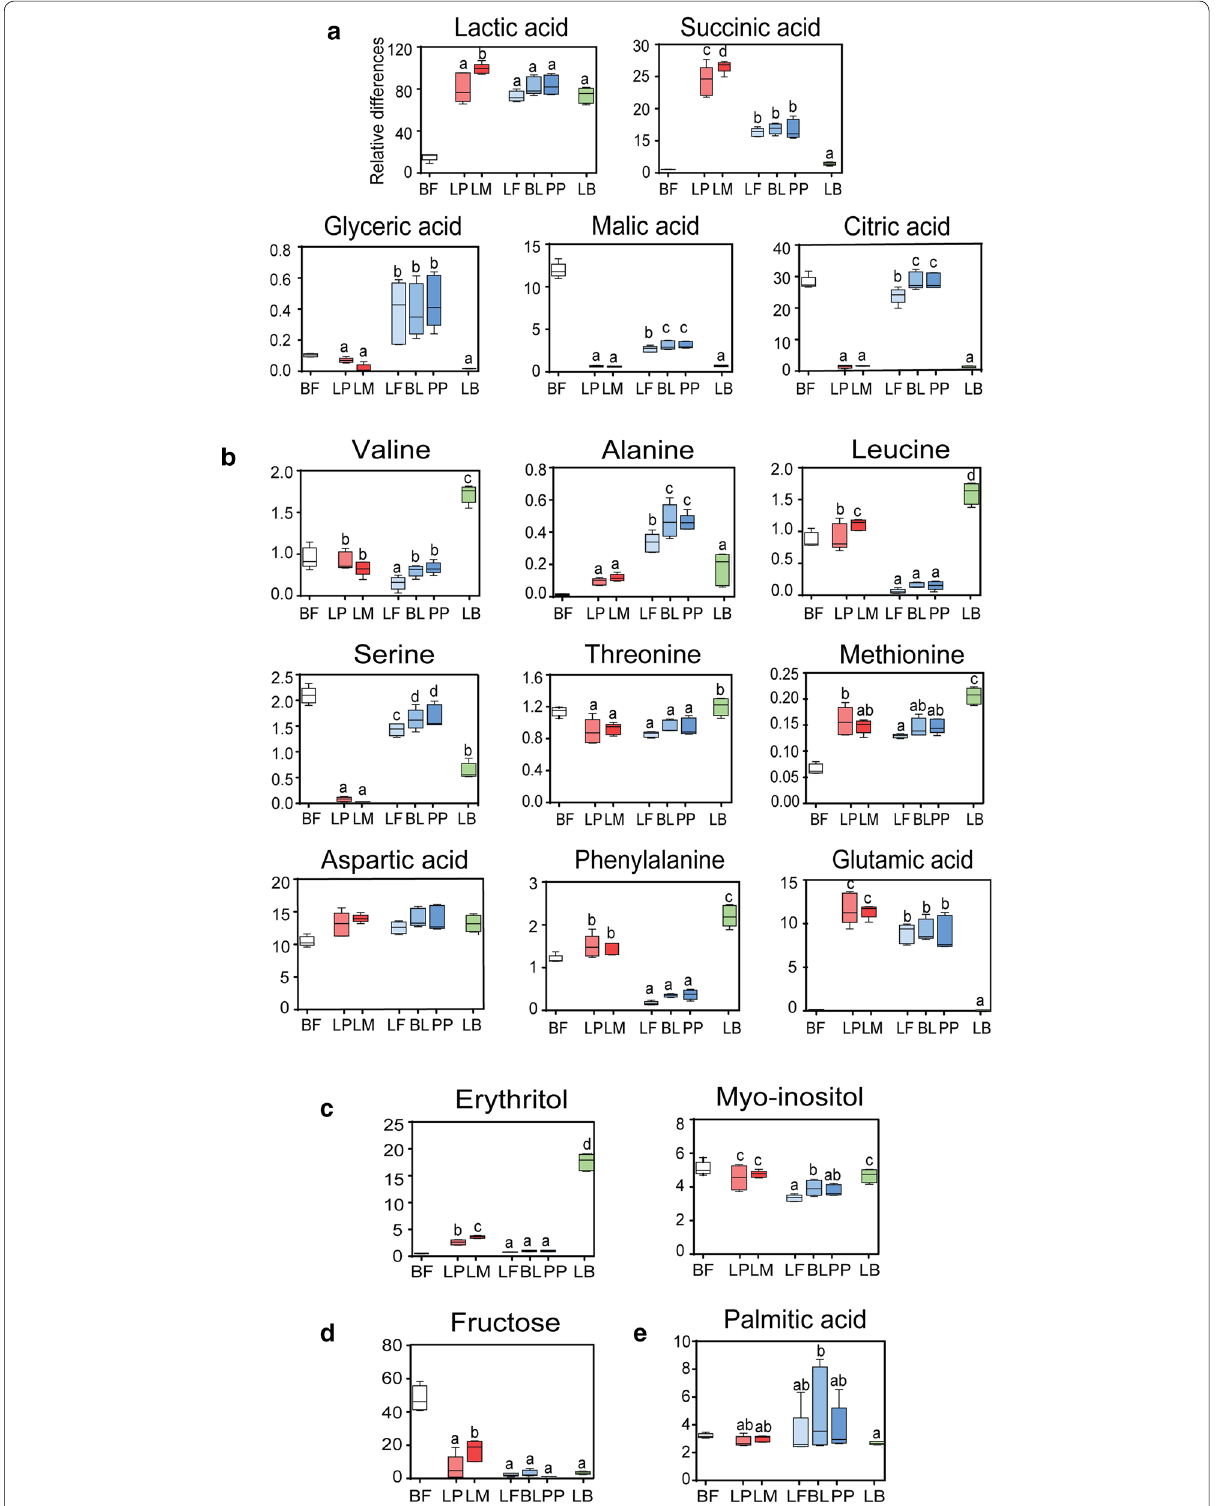
Fig. 4 Box plots of identified metabolites, including organic acids ( a ), amino acids ( b ), polyol ( c ), sugar ( d ), and fatty acid ( e ) in fermented tomatoes. Means followed by different letters are significantly different between samples ( p <